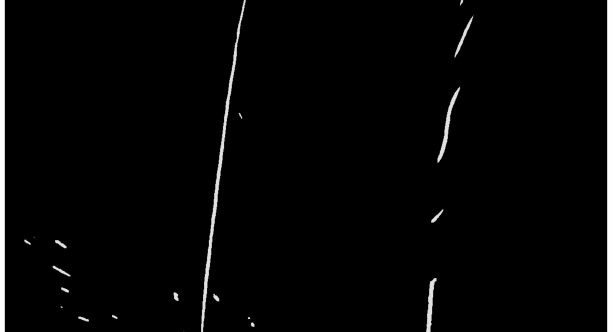
Figure 8. The detection image after mask